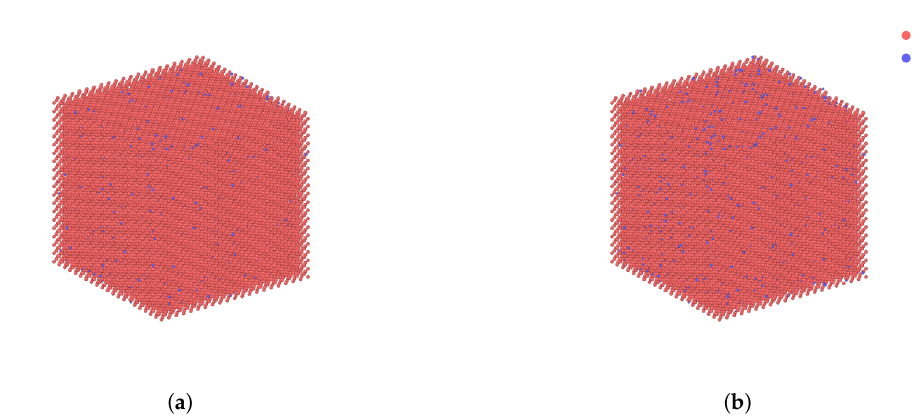
Figure 2. Original configurations of the Cu-Zn alloys with zinc contents of ( a ) 2.5% and ( b )